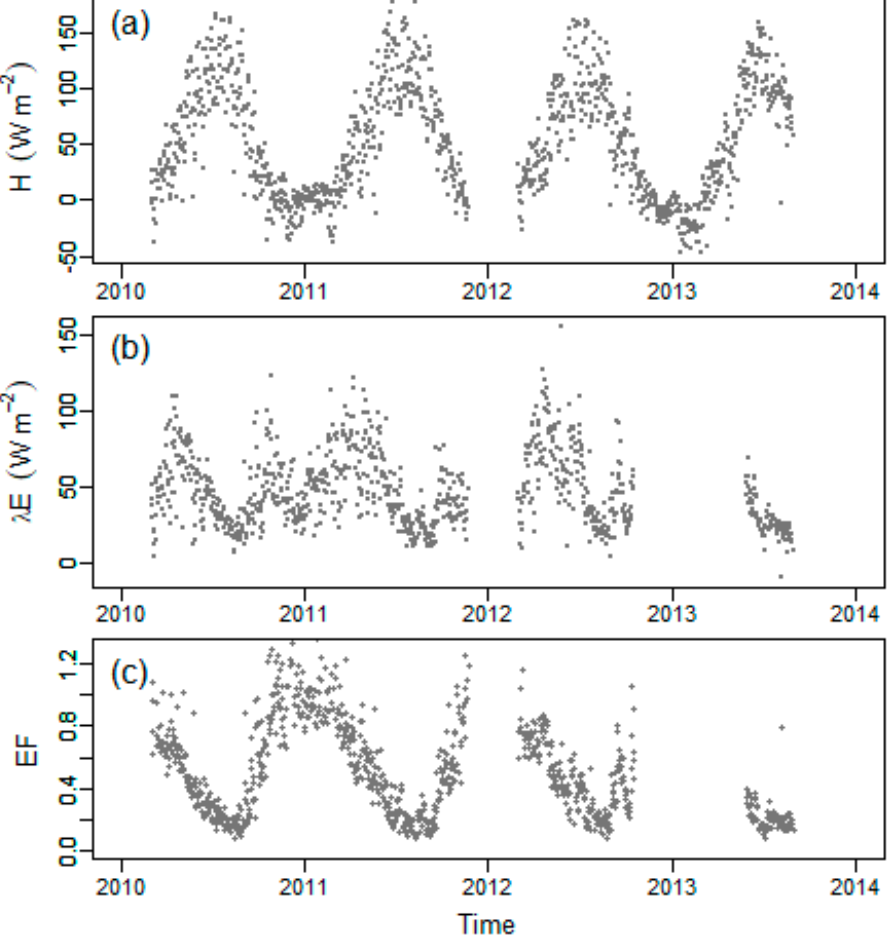
Figure 5. Seasonal evolution of the land surface fluxes at the daily timescale. ( a ) Sensible heat flux (H); ( b ) Latent heat fluxes ( λ E); ( c ) Evaporative fraction (EF).